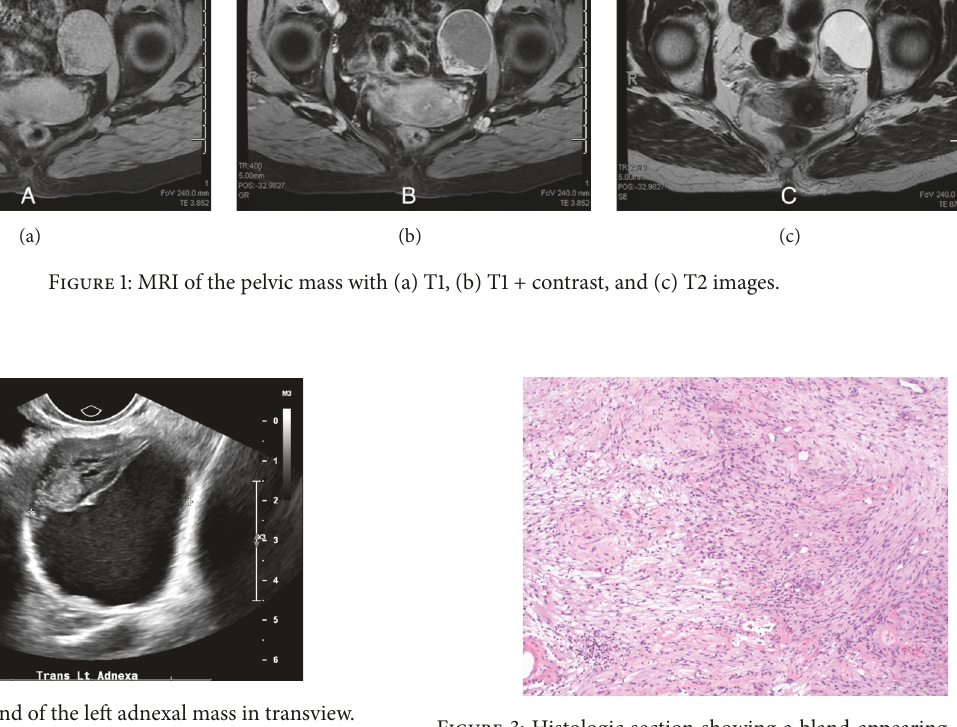
Figure 3: Histologic section showing a bland-appearing, spindled cell proliferation with regions of higher cellularity (Antoni A) interlaced with those of lesser cellularity (Antoni B) (H&E stain, 200x original